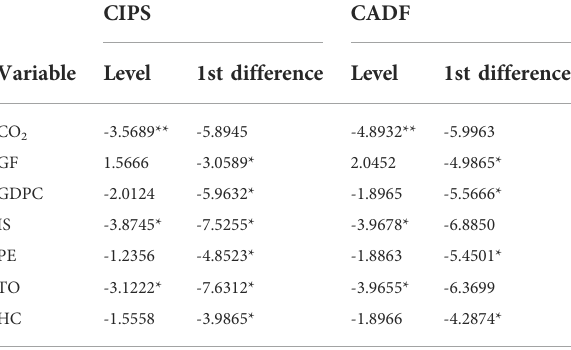
TABLE 4 CADF and CIPS unit root tests. TABLE 5 Westerlund and Edgerton (2008)